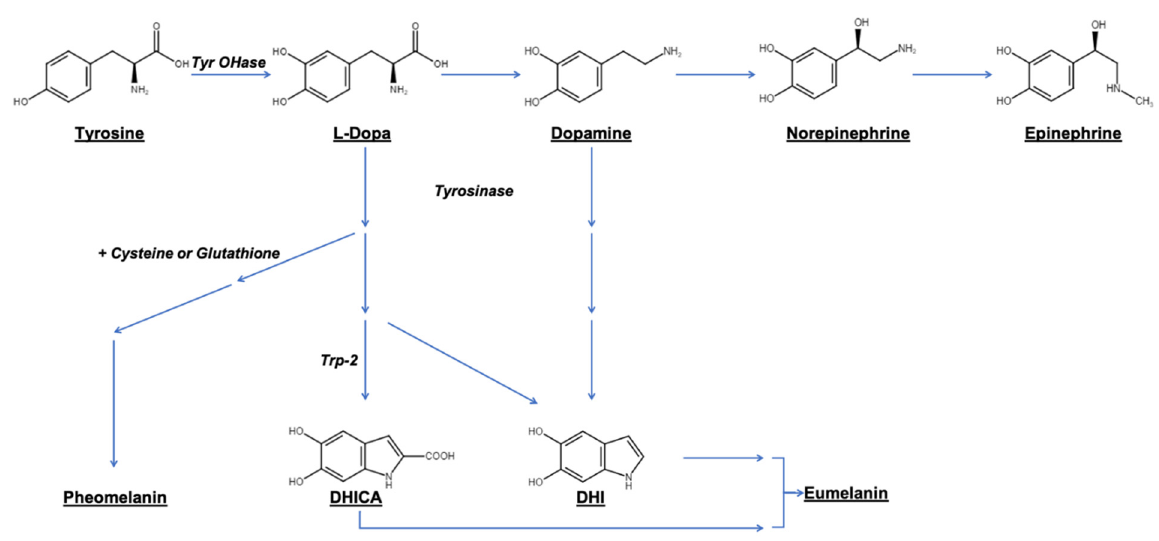
Figure 2. Schematic illustration of main metabolic pathways for eumelanin and pheomelanin synthesis. DHICA: dihydroxyindole carboxylic acid; DHI: 5, 6-dihydroxyindole.